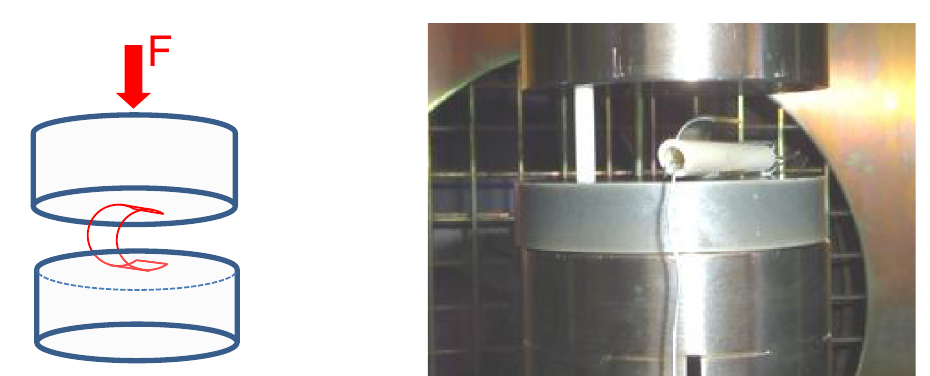
Fig. 2. Principle of “ C ” -shaped ring Compression Test (CCT) between two fl at